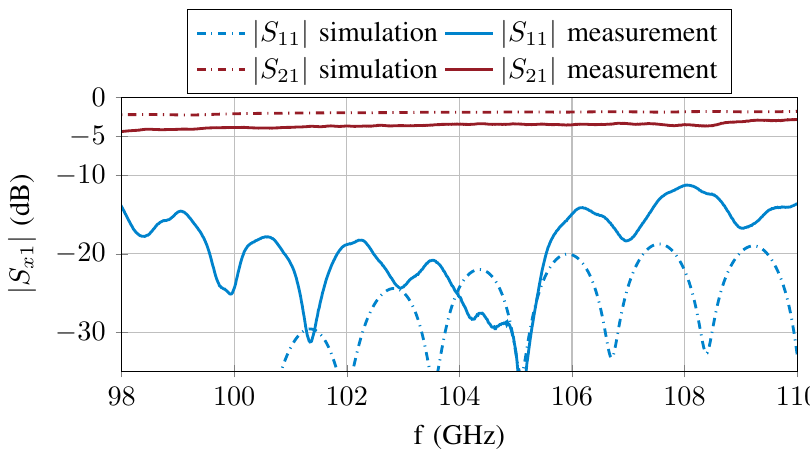
Figure 26. Simulated and measured S-parameters of the NRD phase shifter.